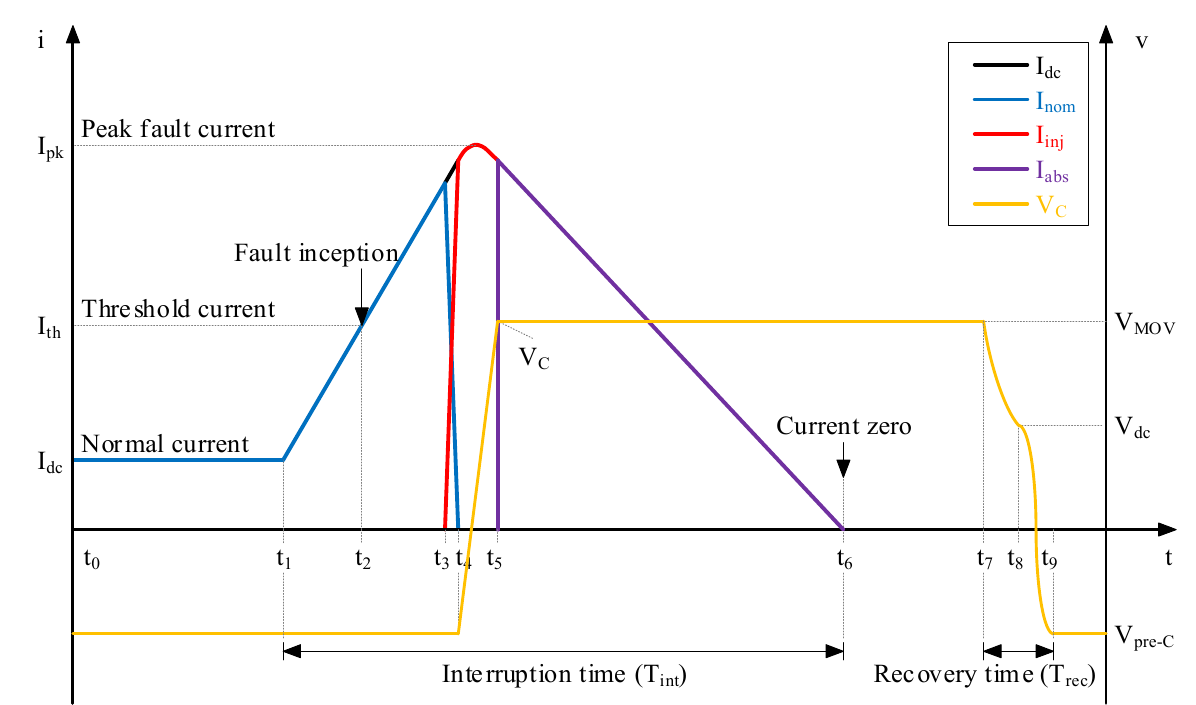
Figure 2. Waveform of current and voltage in the branches of the HCB